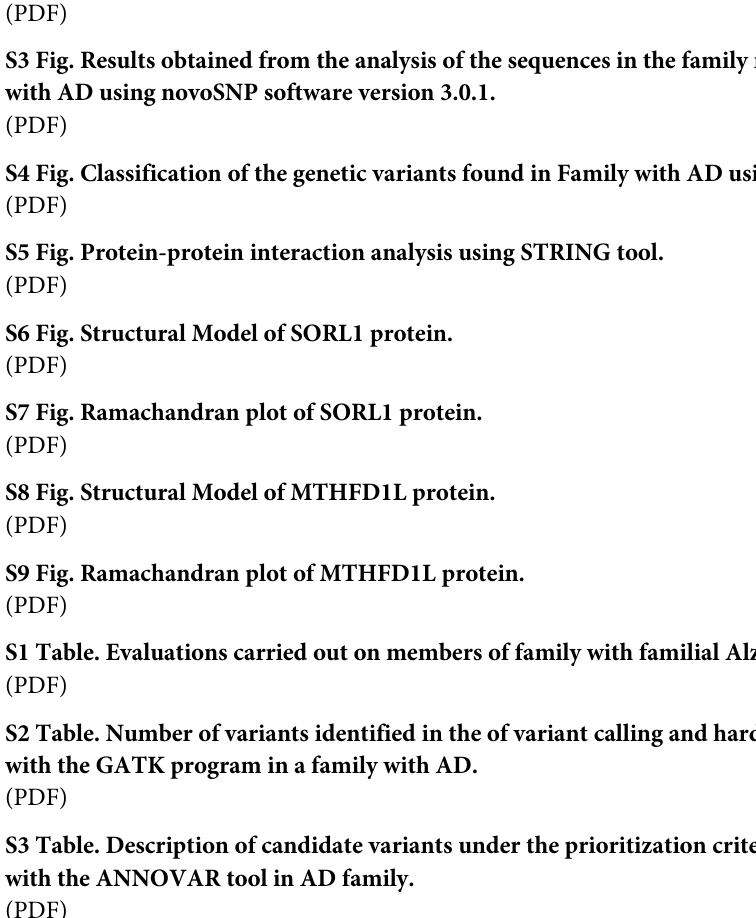
S1 Table. Evaluations carried out on members of family with familial Alzheimer’s disease. S2 Table. Number of variants identified in the of variant calling and hard filtering process with the GATK program in a family with AD. S3 Table. Description of candidate variants under the prioritization criteria identified with the ANNOVAR tool in AD